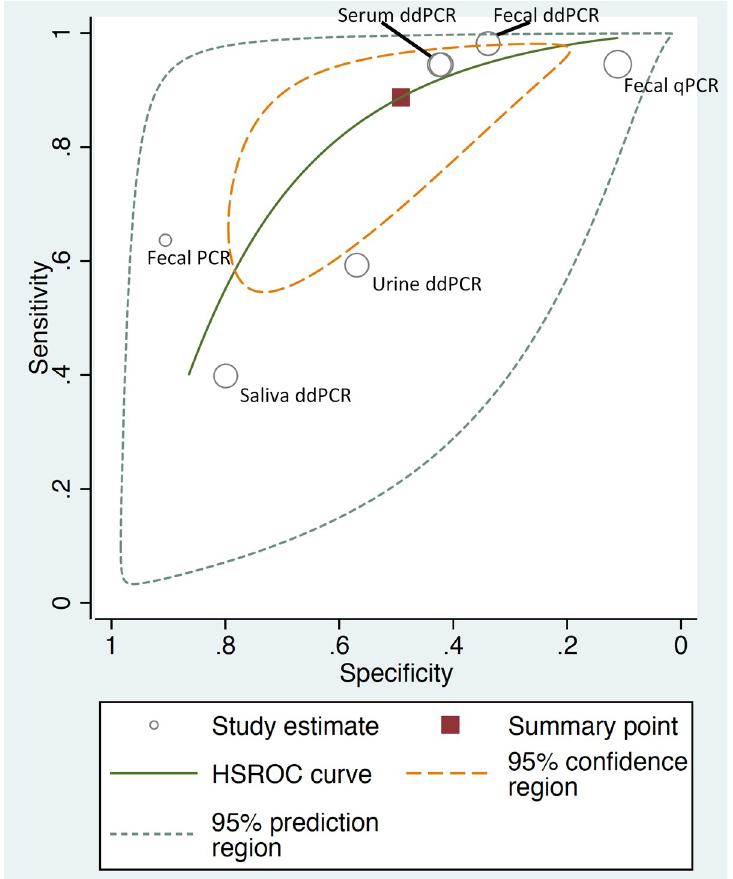
Fig 7. HSROC curve for PCR ( S . japonicum with stool examination as a reference standard).